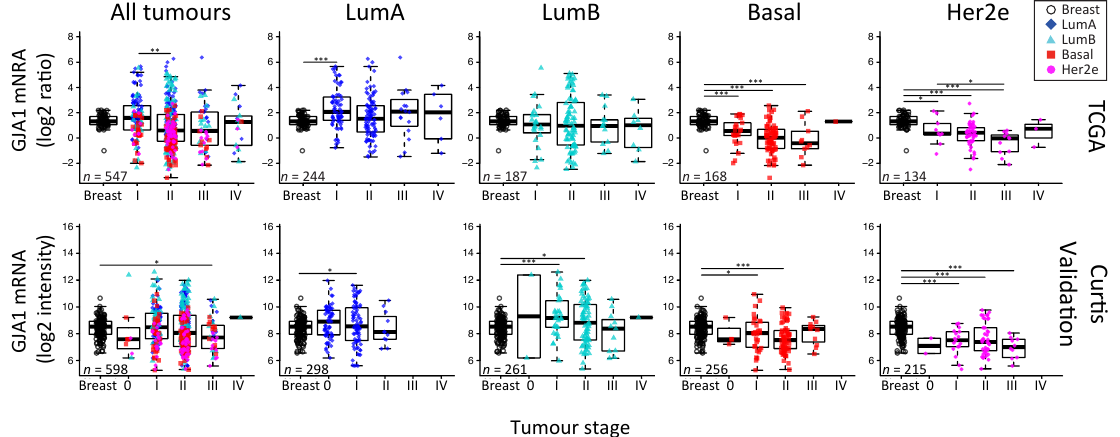
Figure A5. GJA1 mRNA level is dysregulated in the early stages of breast cancer in clinical samples. GJA1 mRNA level for each tumor stage either in pooled breast tumors or stratified by intrinsic subtype. Data from TCGA and Curtis Validation datasets. In the legend, “Breast” indicates adjacent normal breast tissue. p value: * <0.05; ** <0.01; *** <0.001.